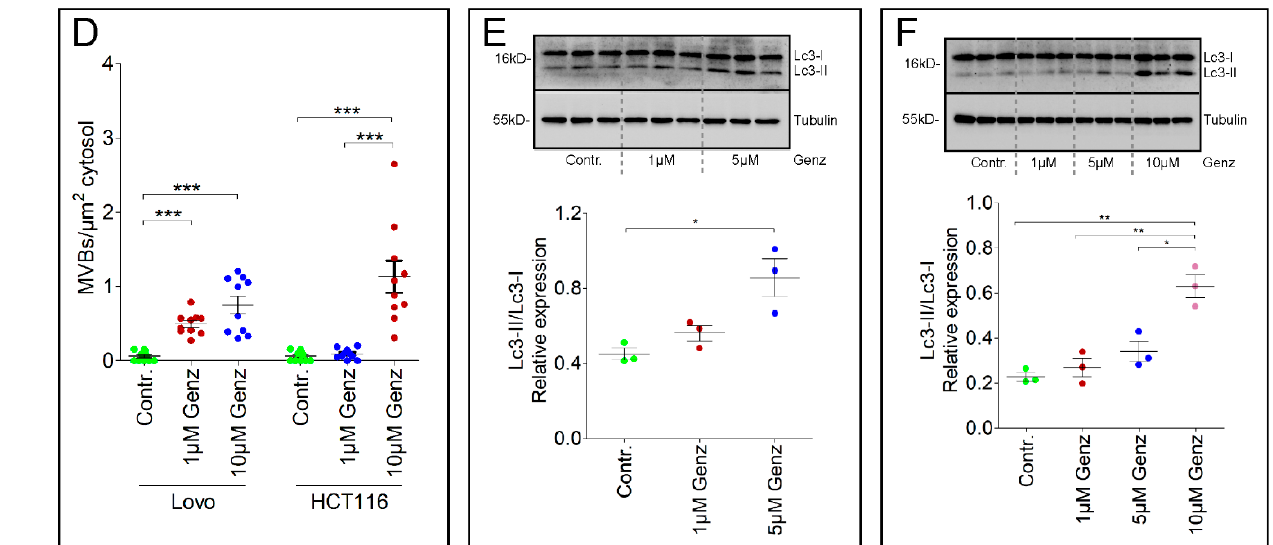
Figure 5. Lovo and HCT116 cells present an elevated number of multivesicular bodies (MVBs) which contain conspicuous structured vesicles upon Genz treatment. ( A ) The number of multivesicular bodies with vesicles displaying multilamellar structures was elevated in Genz-treated colon carcinoma cells. MVB-number increased markedly with 1 µ M Genz in Lovo cells. Only low numbers of MVBs were seen in HCT116 cells upon treatment with 1 µ M Genz. The numbers of MVBs rose markedly with higher Genz concentrations; scale bars, 1 µ m. ( B ) Vesicles inside MVBs of Lovo cells were canonically spheroid, with potential to form onion-like superstructures and myelin-like compaction of stacked membranes ( B , insert). ( C ) MVBs of HCT116 cells displayed angular overall shapes (here triangular), a combination of apparently stiff sheets with sharp cornered rims. The insert demonstrates a widening of the expectedly lipophilic middle-leaflet of the canonical bi-laminar unit-membrane (arrowhead), scale bars in ( B , D ), 500 nm; in insets 100 nm. ( D ) The number of MVBs increased with elevated Genz-concentrations; shown are mean numbers of MVBs per µ m 2 cytosol, each from 10 cells. ( E , F ) The expression levels of the autophagy marker Lc3-II rose markedly in both Lovo- ( E ) and HCT116 cells ( F ) upon increased Genz concentrations; significances are *, p ≤ 0.05; **, p < 0.01; ***, p <